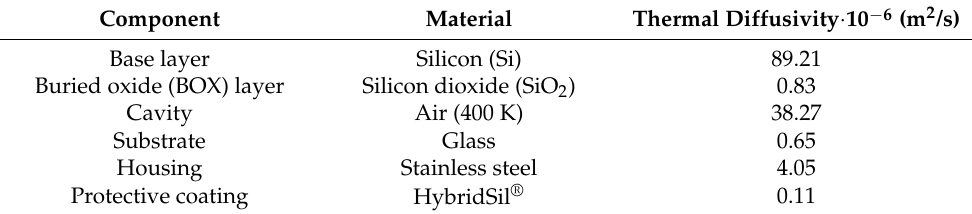
Table 1. Initial thermal diffusivity of the sensor